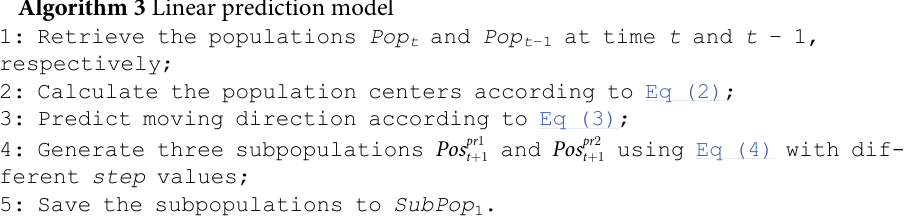
Algorithm 3 Linear prediction model